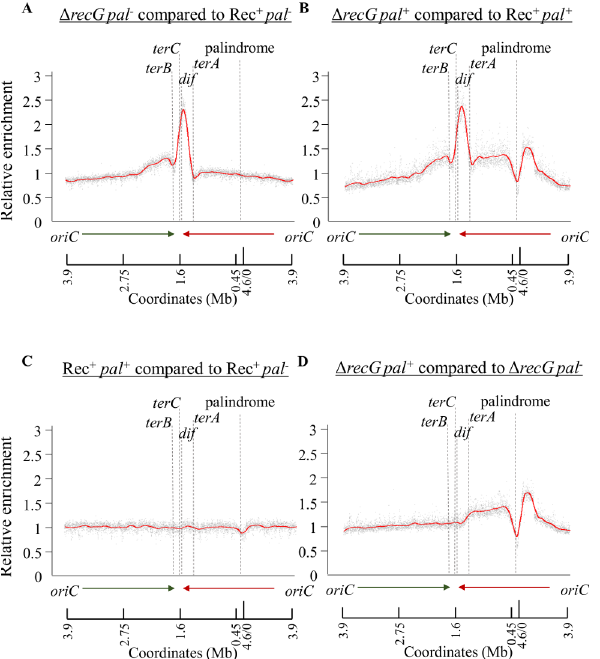
Fig 2. MFA profiles of Δ recG mutants and Rec + strains of E . coli as a consequence of attempted DSBR at the lacZ locus. The ratio of the normalized DNA copy number (or “ relative enrichment ” ) of uniquely mapped sequence reads from exponentially growing cultures of the strains of interest are plotted along the y - axis against replichore-formatted genomic coordinates along the x -axis. The average relative enrichment of DNA in a Δ recG mutant to a Rec + strain is shown in the absence (A) or in the presence of an induced break at the palindrome (C), between Rec + strains and Δ recG mutants in the presence and in the absence of an induced break at the palindrome (C-D). The relative positions of the replication termination sites ( terB , terC and terA ), dif site and the location of palindrome are shown for each plot. The data are the averages of the two biological replicates shown individually in supporting Information S1 Fig and S2 Fig. Strains used were DL4184 (Rec + Pal + ), DL4201 (Rec + Pal - ), DL4311 ( Δ recG Pal + ), and DL4312 ( Δ recG Pal - ).